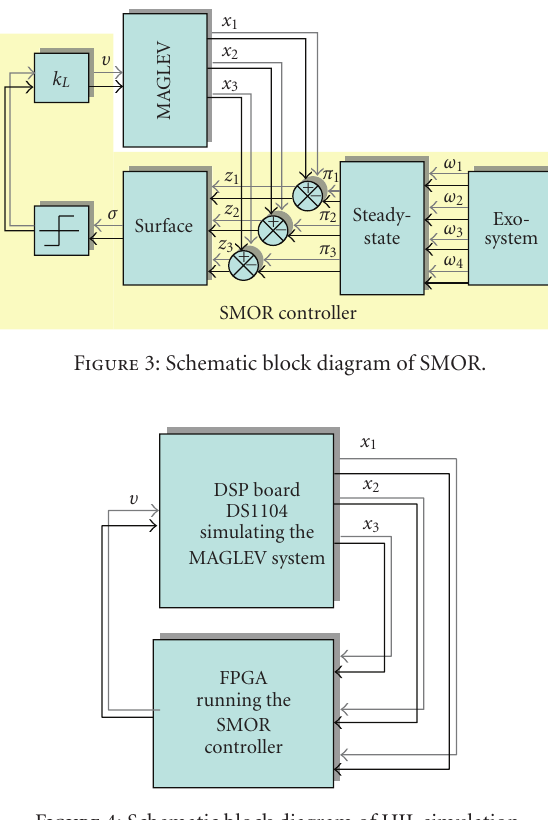
Figure 4: Schematic block diagram of HIL simulation.